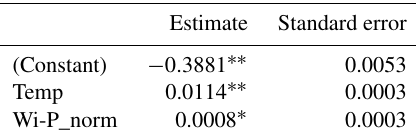
Table 14. Parameter estimation in the regression